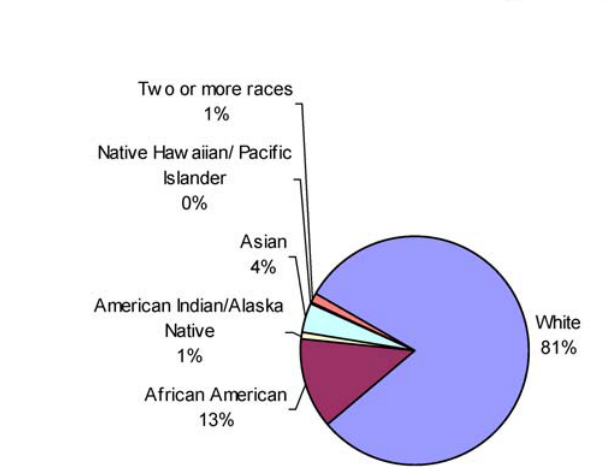
Figure 1. Ethnic and Racial Composition of the United States Data from year 2003. DOI: 10.1371/journal.pmed.0030019.g001 PLoS Medicine |